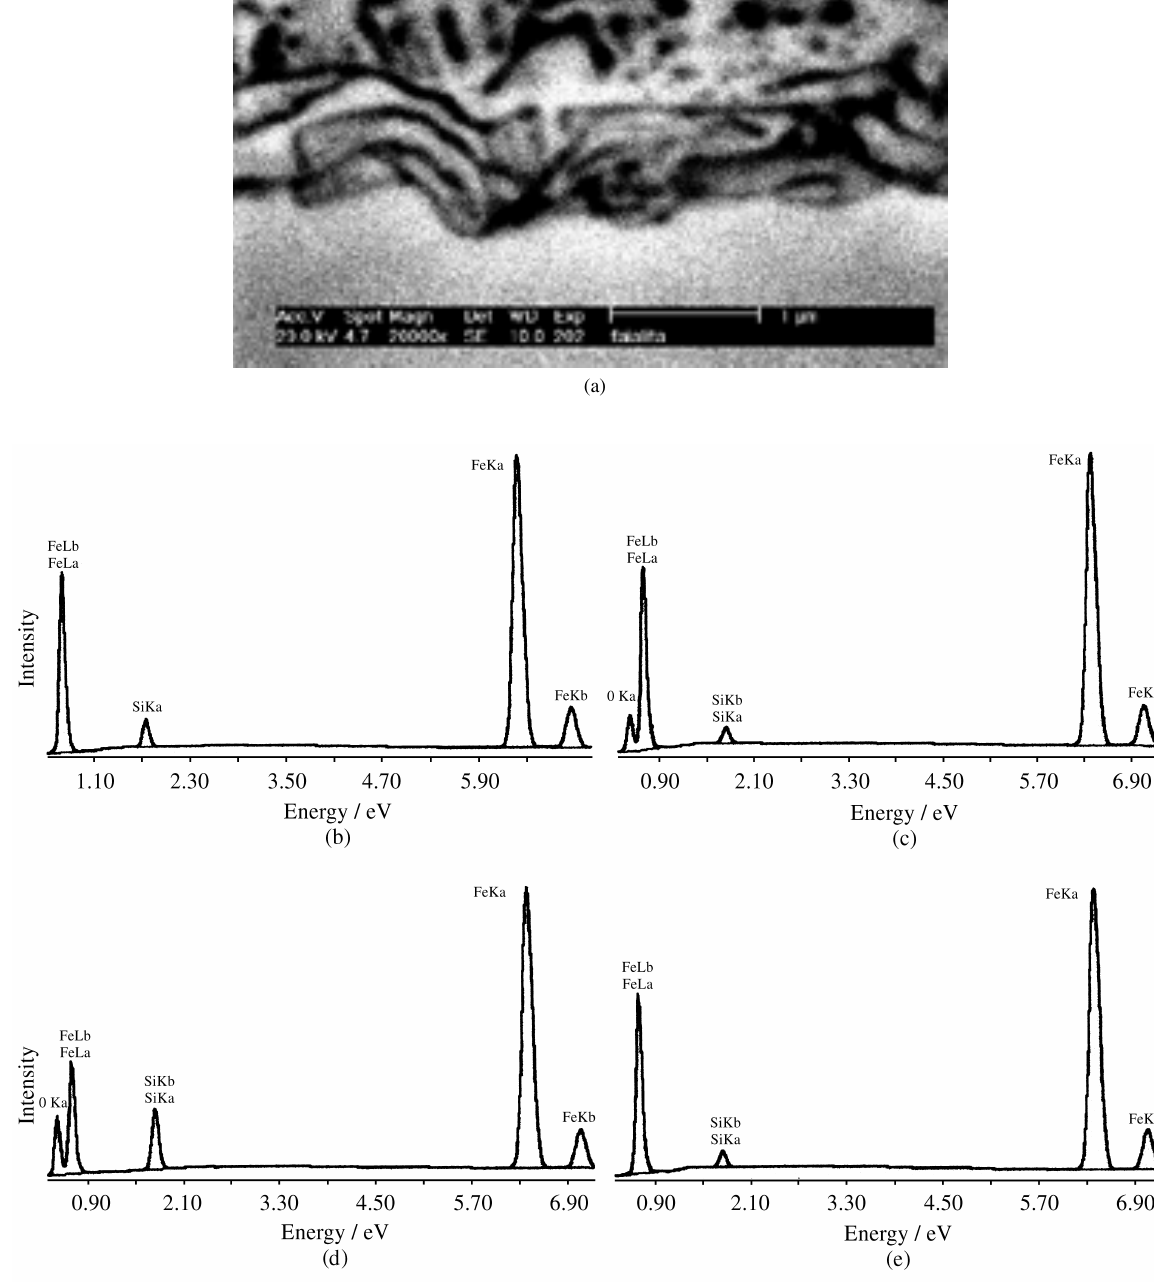
Figure 1. Typical oxide layer formed on the surface of the steel substrate. (a) 20000X; EDS spectrum for (b) point 1; (c) point 2; (d) point 3 and (e) point